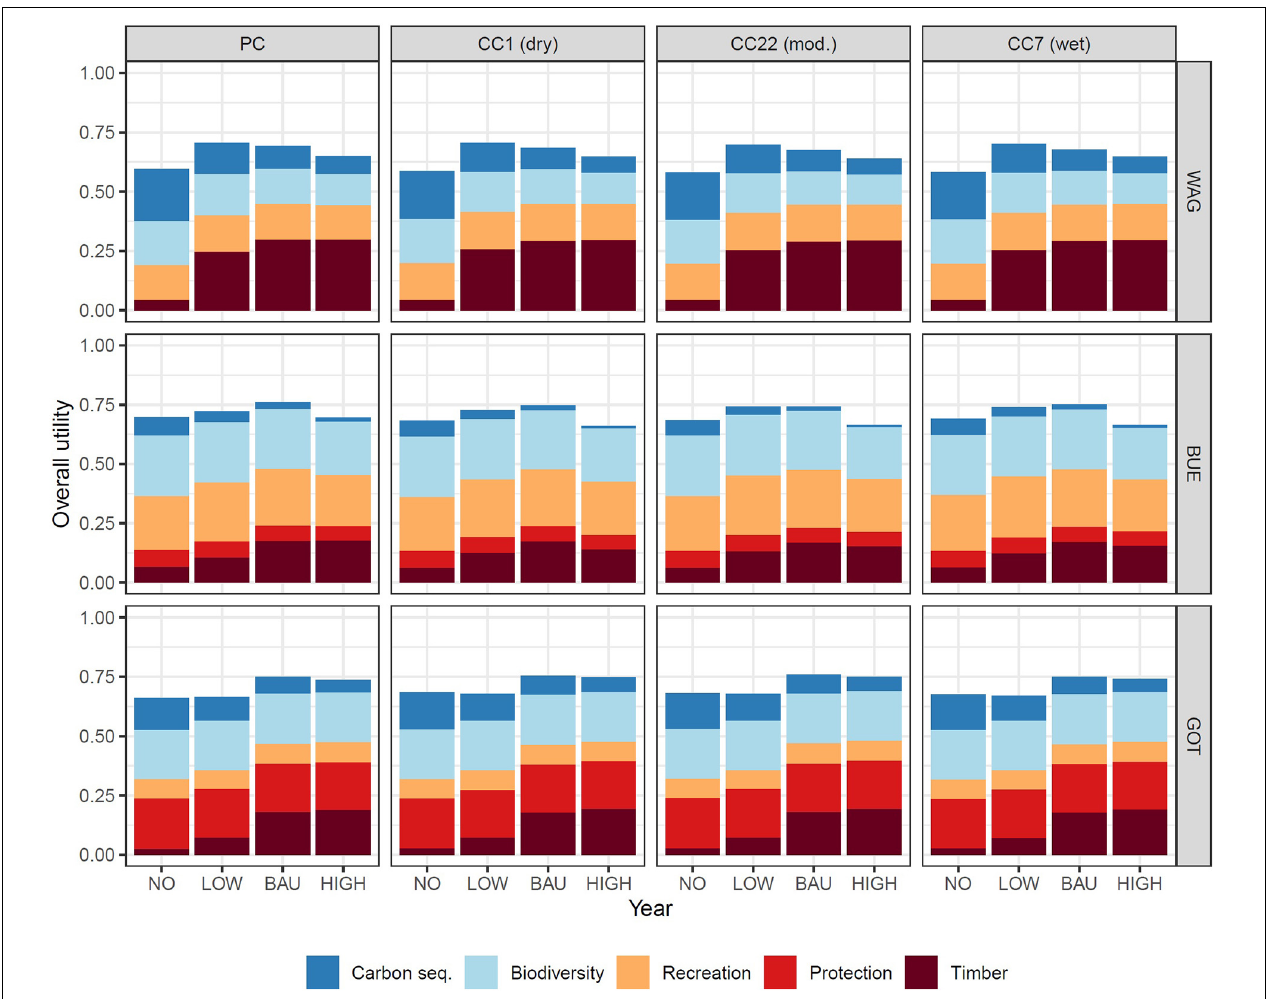
FIGURE 5 | Overall utility, shown as the sum of weighted partial utilities (based on ‘Current weight’, see Table 4 ) for all biodiversity and ecosystem service (BES) indicators for four management strategies at the three case study enterprises (WAG, BUE, GOT) under present climate (PC) as well as three future climate change scenarios (CC1: dry, CC7: wet, CC22: moderate) for the year